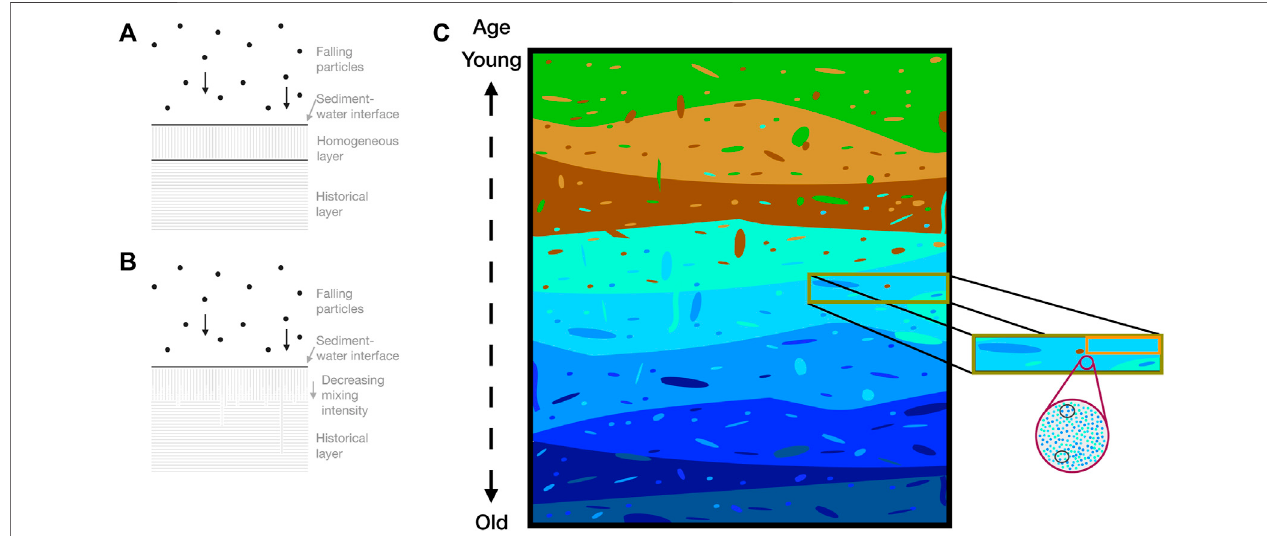
FIGURE 1 | Conceptual sketches of mixing processes and sediment heterogeneity in a marine environment. Following the traditional terms of the mixed and the historicallayer, (A) showsawell-de fi nedboundarybetweenbothlayerswhile (B) showsmoredynamicmixingprocessesincludingdeepreachingburrows. (C) illustrates a potential two-dimensional view of the heterogeneous distribution of consistently increasing ages with depth. The panels on the right hand side show a zoom into local age-heterogeneity. Colored dots and areas indicate marks from mixing of fi ne materials, fossils and other detrital components.